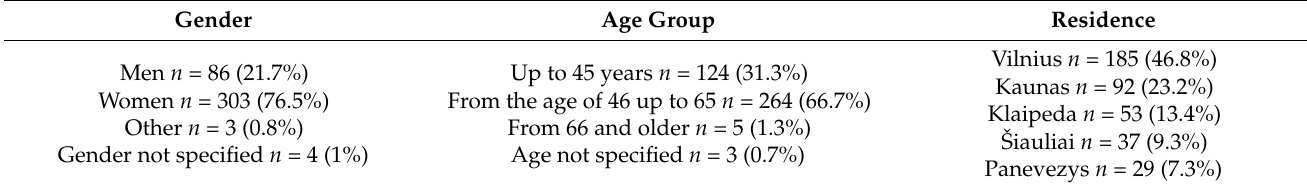
Table 1. Demographic assessments of subjects ( n = 396;